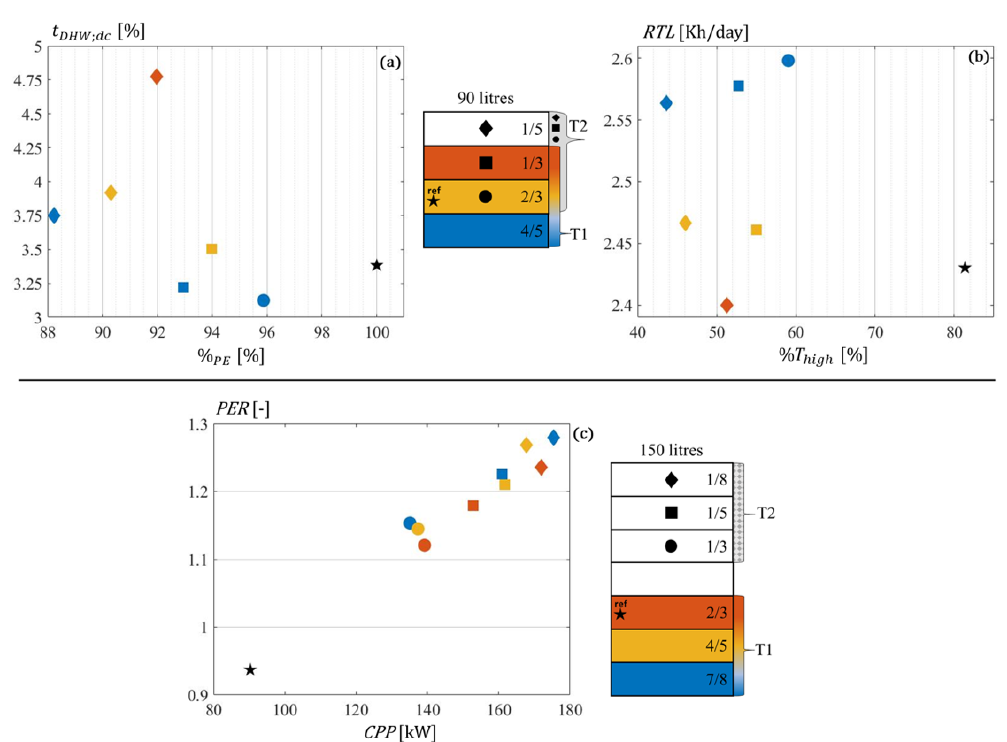
Figure 7. Two-sensor control: Pareto analyses on the sensors’ positions in 90 L vessels ( a ) for t DHW ; dc and % PE , and ( b ) for RTL and % T high ; and in 150 L vessels ( c ) for PER and CPP. The 90 L vessel has four water layers in which place the temperature sensors, and the 150 L one has seven. The colour refers to the place of the lower sensor (T1), and the shape refers to the position of the upper sensor (T2). For example, the blue square for 90 L means that T1 is at 4/5 of the height of the vessel (layer 4), and T2 is to 1/3 of the height (layer 2). The reference is the reference control strategy (600 kg/h charging flow rate) with the sensor placed at 2/3 of the height, for 90 L or 150 L vessels (depending on the